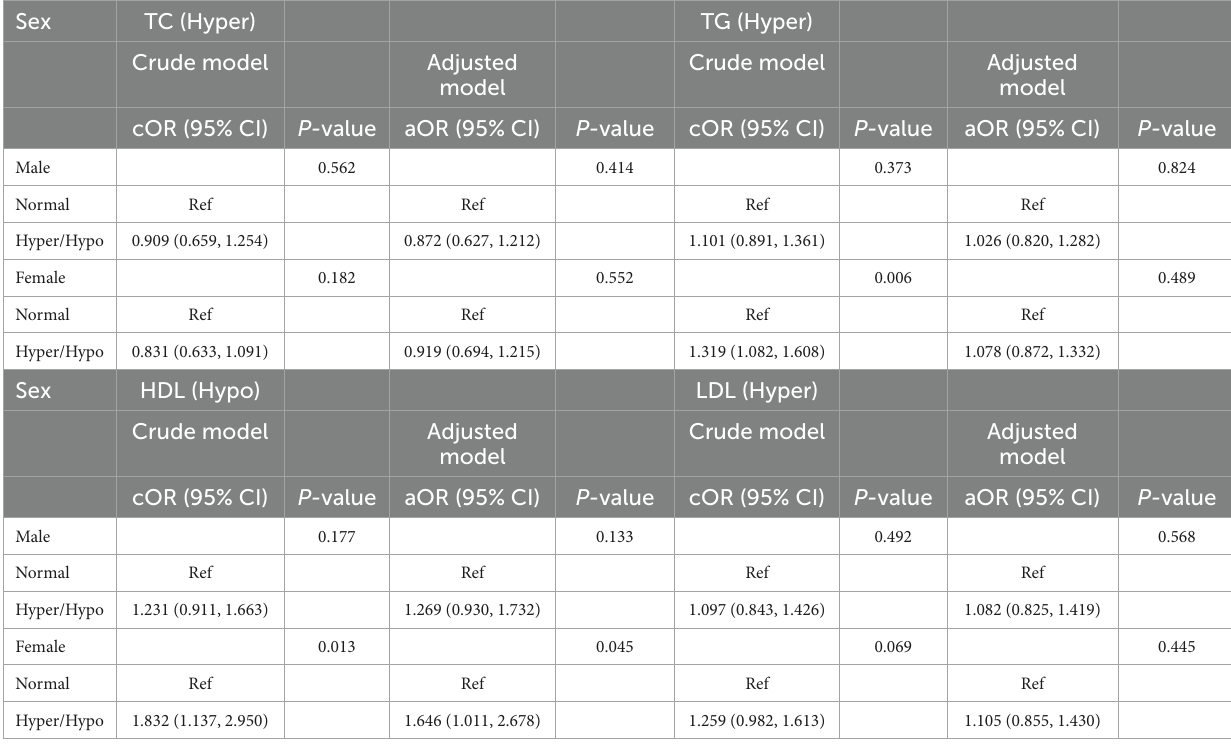
TABLE 4 Odds ratios for associations between triglyceride and cholesterol levels and anti-HBs results stratified by